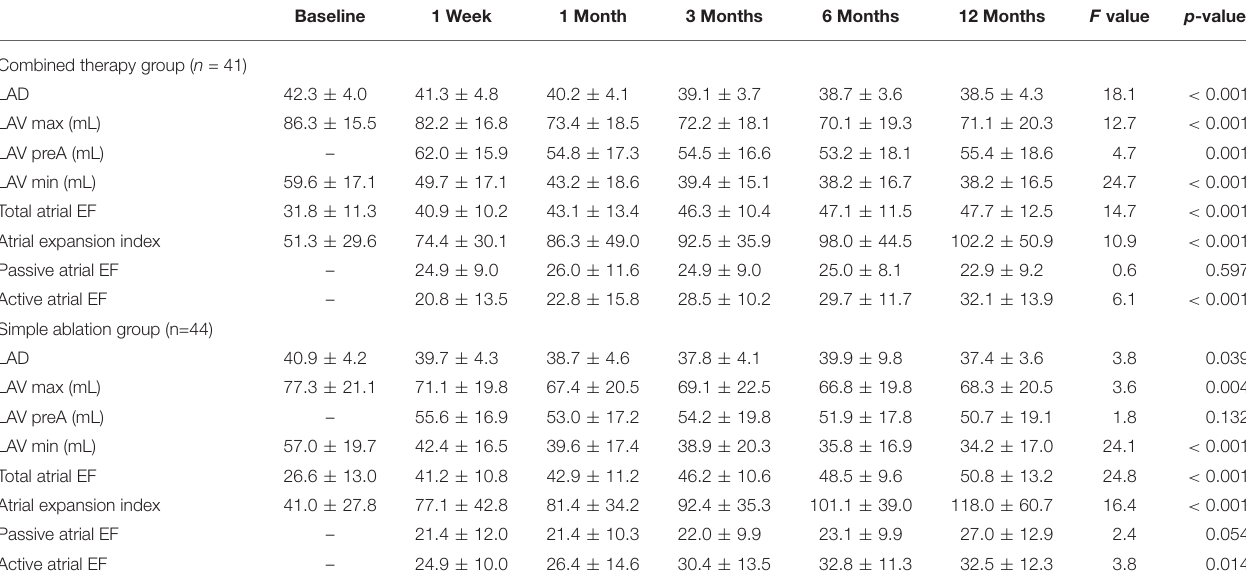
TABLE 2 | Evolution of LA function after the LAAC combined with CA and simple CA group assessed volumetric indices.